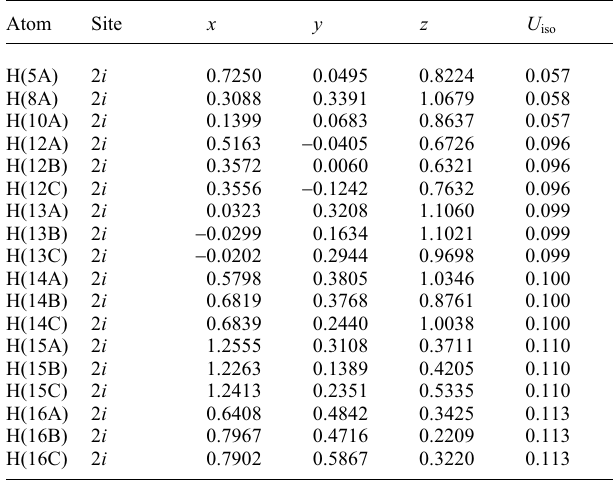
The structure of title compound is composed of a planar pyrimi- figure). The two rings were found to be linked by a methylidene bridge (C5–C4 = 1.334(3) Å) and found to positioned roughly at right angle to each other. In the crystal van der Waals forces only are found between molecules. In the crystal structure the mole- cules were found to be arranged parallel to a -axis in a zigzag fash- ion. Table 2. Atomic coordinates and displacement parameters (in Å 2 )